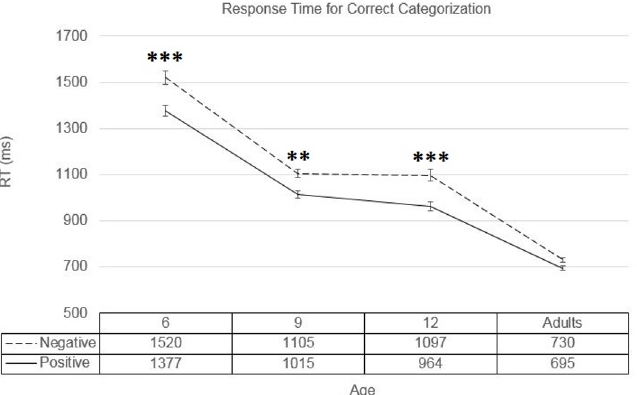
Fig 3. Measures of correct response times. Response times for correct categorization trials for positive and negative faces for all age groups. Stars indicate the significance level of differences between positive and negative faces within each corresponding age group. Error bars represent standard